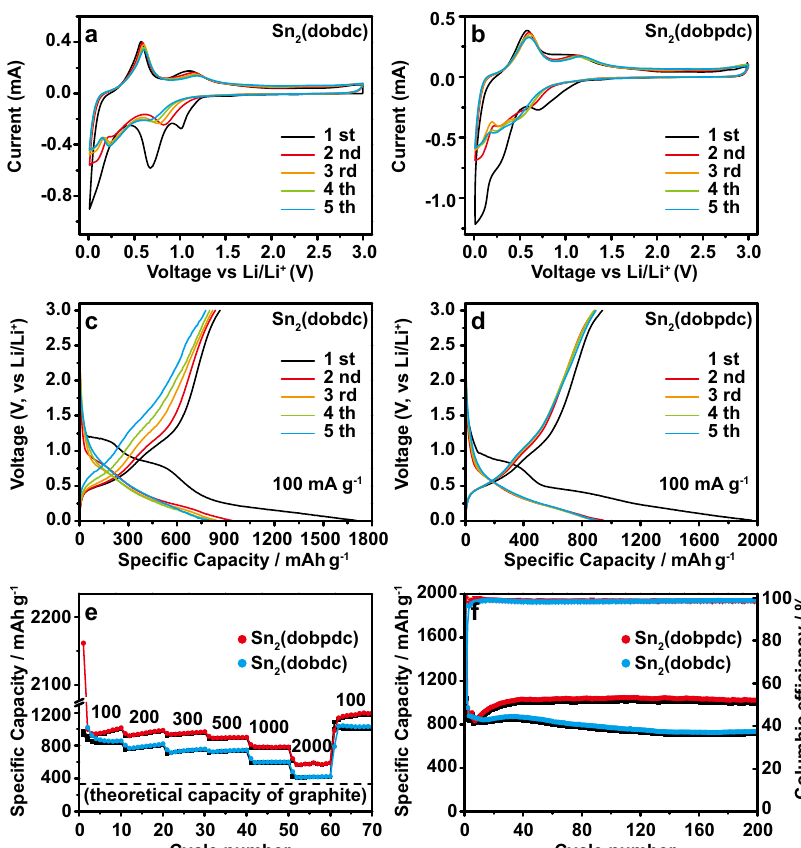
Fig. 2 Electrochemical performance of Sn 2 (dobdc) and Sn 2 (dobpdc). a , b CV curves at 0.1 mV s – 1 of Sn 2 (dobdc) and Sn 2 (dobpdc). c , d Discharge – charge pro fi les of Sn 2 (dobdc) and Sn 2 (dobpdc) in the fi rst fi ve cycles. e , f Rate performance and cycle